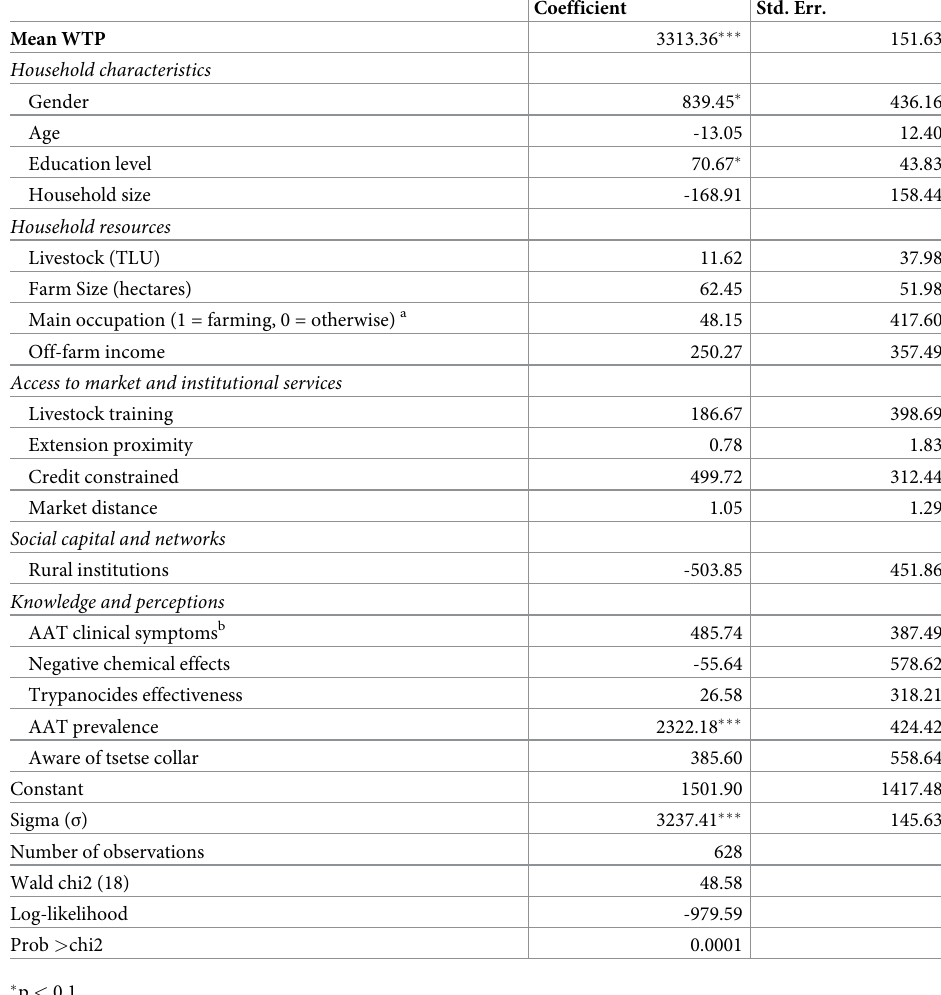
Table 8. Factors influencing the WTP for icipe’s tsetse repellent collar in Kwale